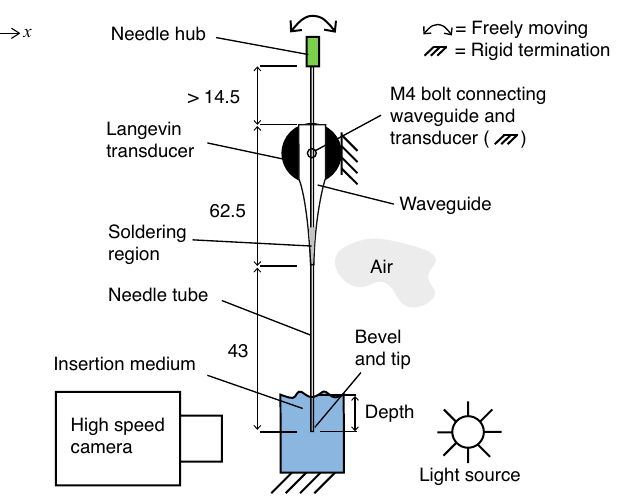
Figure 5. Front-view of experimental setup. Depth was measured from surface of medium. The needle construct was clamped and mounted on a motorised translation stage. A high speed camera with a high- magnification lens (5 ) was used to measure the deflection of bevel-tip. All dimensions are given in ×